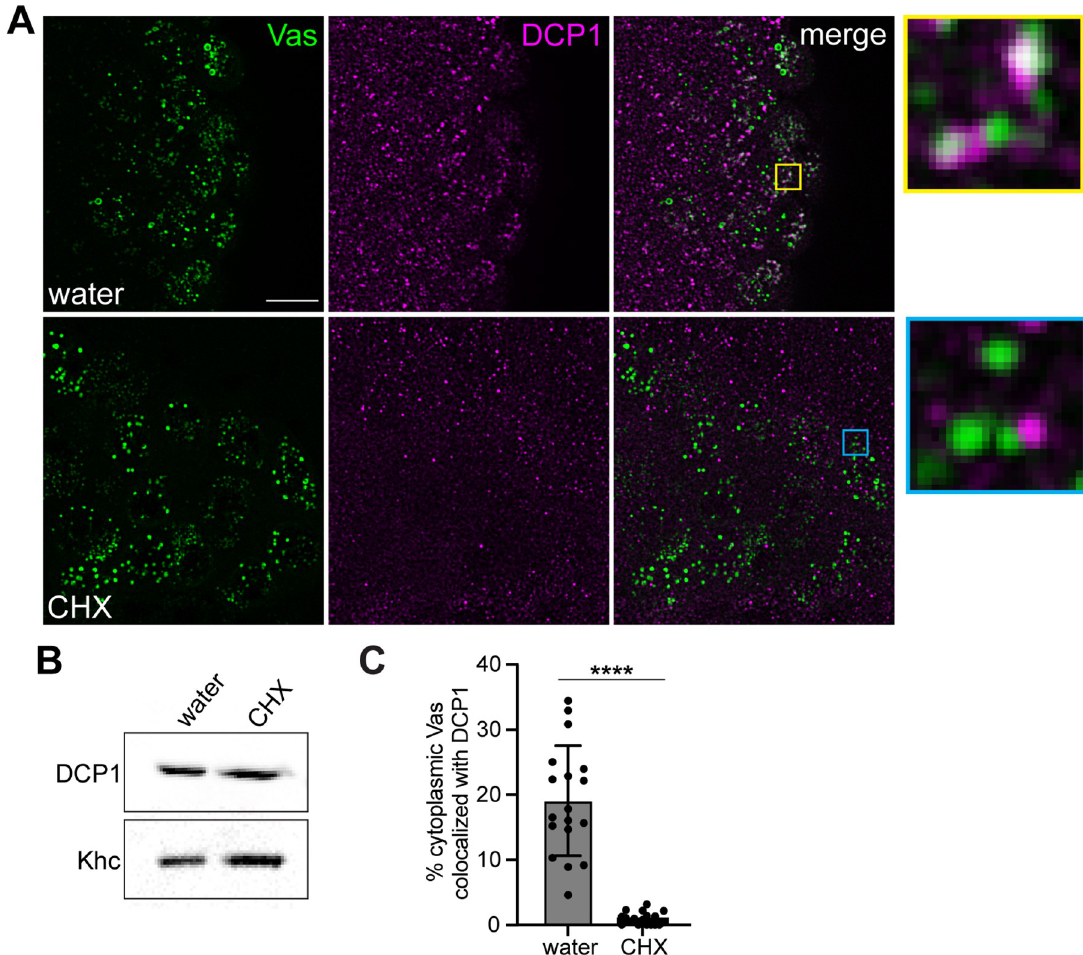
Fig 8. Recruitment of decapping factors to the germ granules is dependent on translation. (A) Maximum intensity confocal z- projections of the posterior of nc14 embryos expressing a vas-egfp transgene to mark the germ plasm after water or CHX injection. Vas- EGFP was detected by direct fluorescence together with anti-DCP1 immunofluorescence. Enlargements of the boxed regions show DCP1 localization to germ granules in water injected (control) embryos (yellow) and the lack of colocalization in CHX injected embryos (cyan). (B) Western blot analysis of DCP1 levels in CHX and water injected embryos. Khc is used as a loading control. For the unprocessed data see S1 Raw Images. (C) The percent of cytoplasmic Vas-EGFP puncta that colocalize with DCP1 was quantified in both injection conditions, n = 18 embryos per condition. Nuclear Vas puncta were masked using Imaris software. Individual data points and mean ± SD are shown. **** p < 0.0001 as determined by Welch’s t test. Source data for the graph in Fig 7C are provided in S1 Data. CHX,